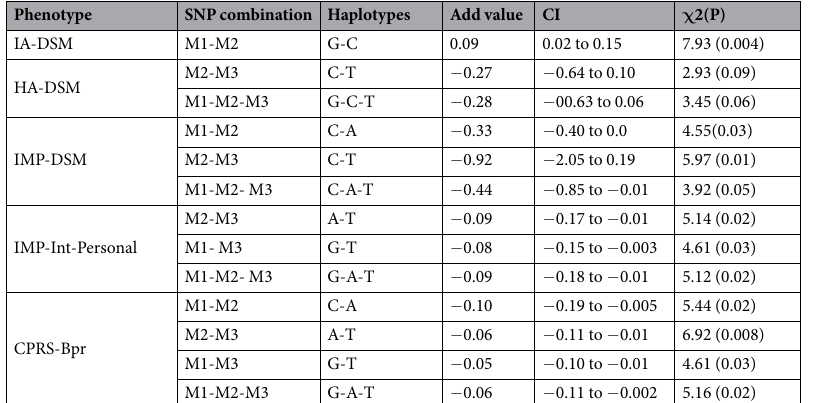
Table 3. Quantitative Trait analysis involving ADHD associated phenotypes and gene variants. N.B: IA-DSM- Inattention score DSM IV; HA-DSM-hyperactivity score DSM-IV; IMP-DSM-impulsivity score DSM; Int-Per- IMP- TSI- interpersonal impulsivity score Tsukayama scale for impulsivity; CPRS-Bpr-Conner’s parent rating scale behavioral problem score.